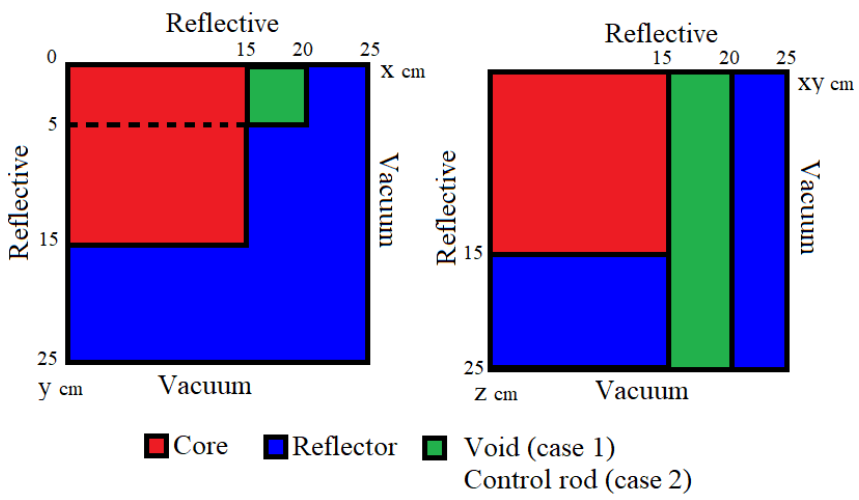
Figure 4. Core configuration of small LWR